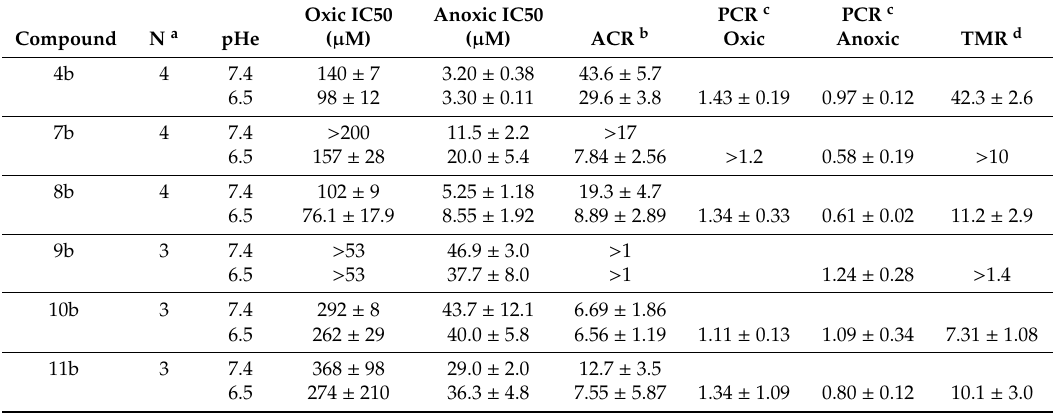
Table 6. Cytotoxicity of BTO esters against FaDu cells by IC 50 assay after 4 h of exposure at pHe 7.4 or 6.5 under oxic or anoxic